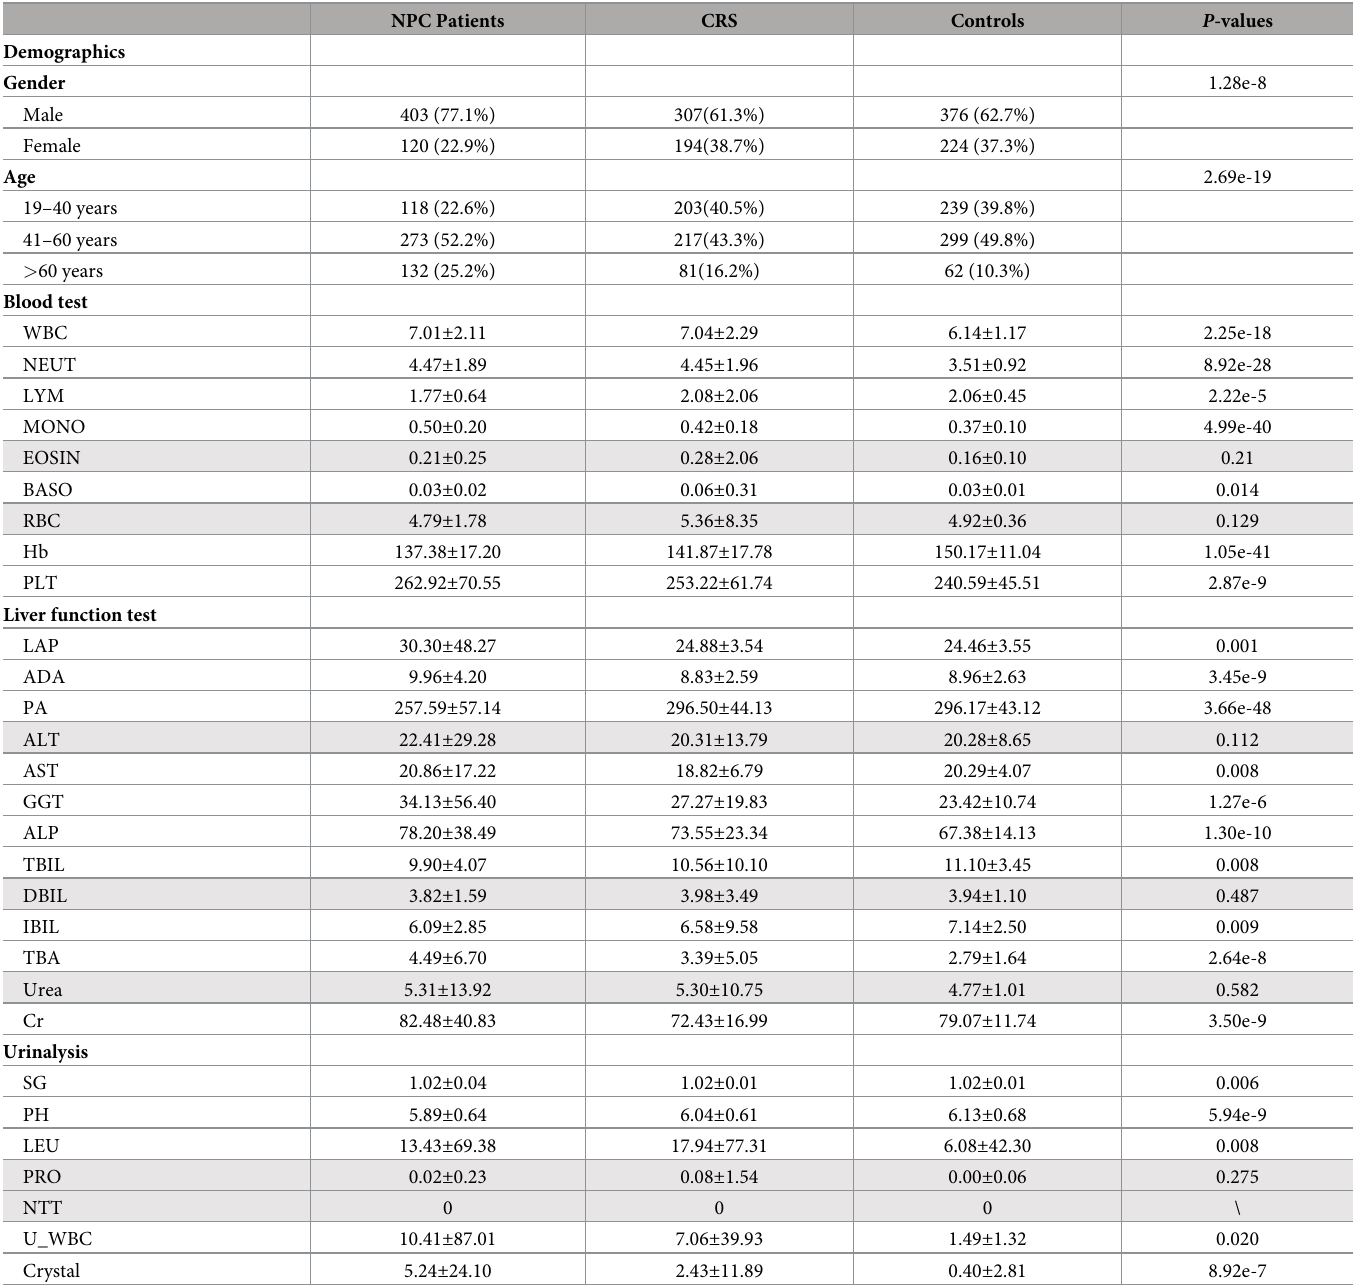
Table 1. The subjects’